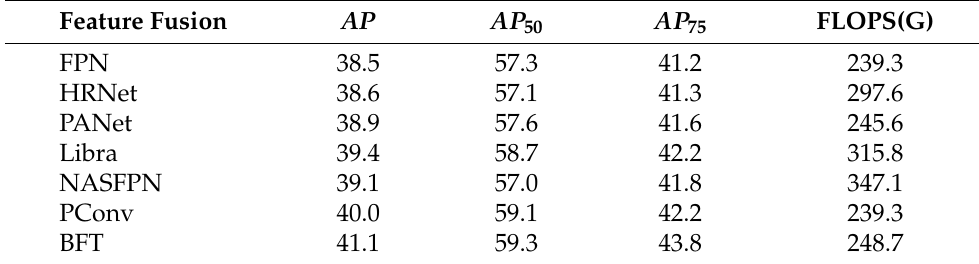
Table 4. Comparison with other feature fusion modules on